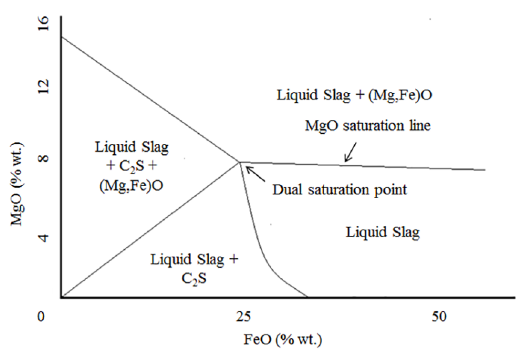
Figure 1. Generic isothermal saturation